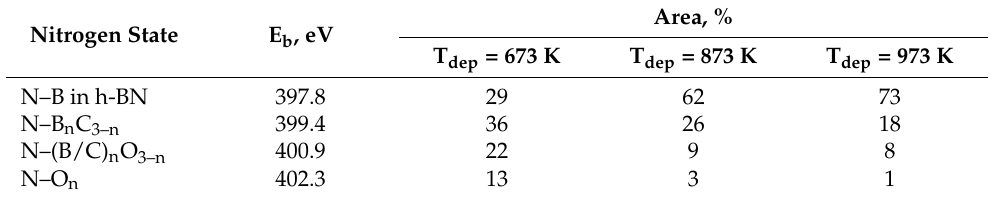
Table 5. Fine structure of N1s spectra of the LPCVD BC x N y films deposited at different